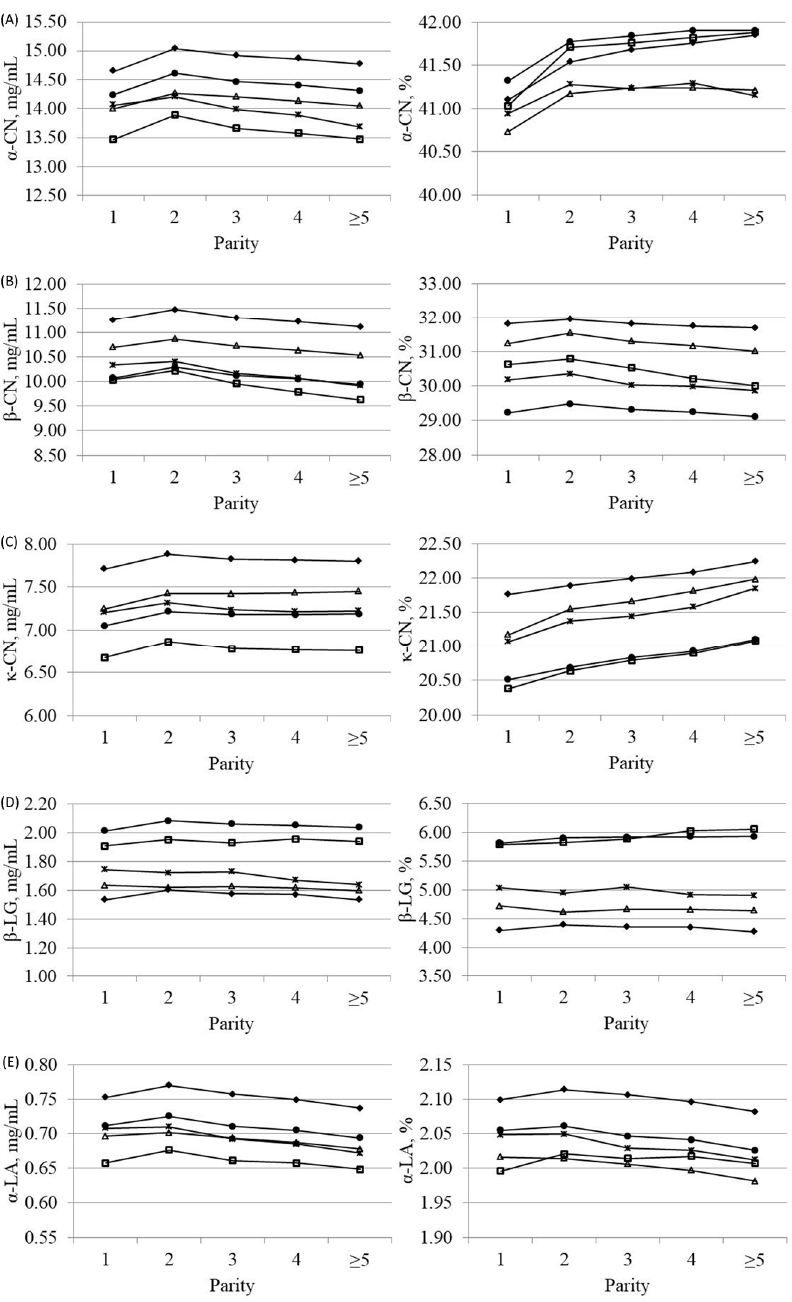
Figure 1. Least squares means of ( A ) α -casein ( α -CN), ( B ) β -casein ( β -CN), ( C ) κ -casein ( κ -CN), ( D ) β -lactoglobulin ( β -LG) and ( E ) α -lactalbumin ( α -LA) across parity for Brown Swiss (- ♦ -), Holstein-Friesian (- □ -), Alpine Grey (- △ -), Simmental (- ● -) and Pinzgauer (-×-) cows, expressed as mg/mL of milk (on the left side) or percentage of crude protein (on the right side).